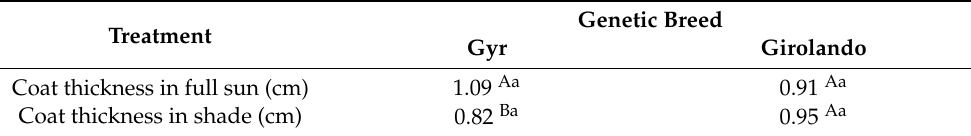
Table 4. Mean coat thickness (cm) according to treatments full sun and ICLF with shade and genetic